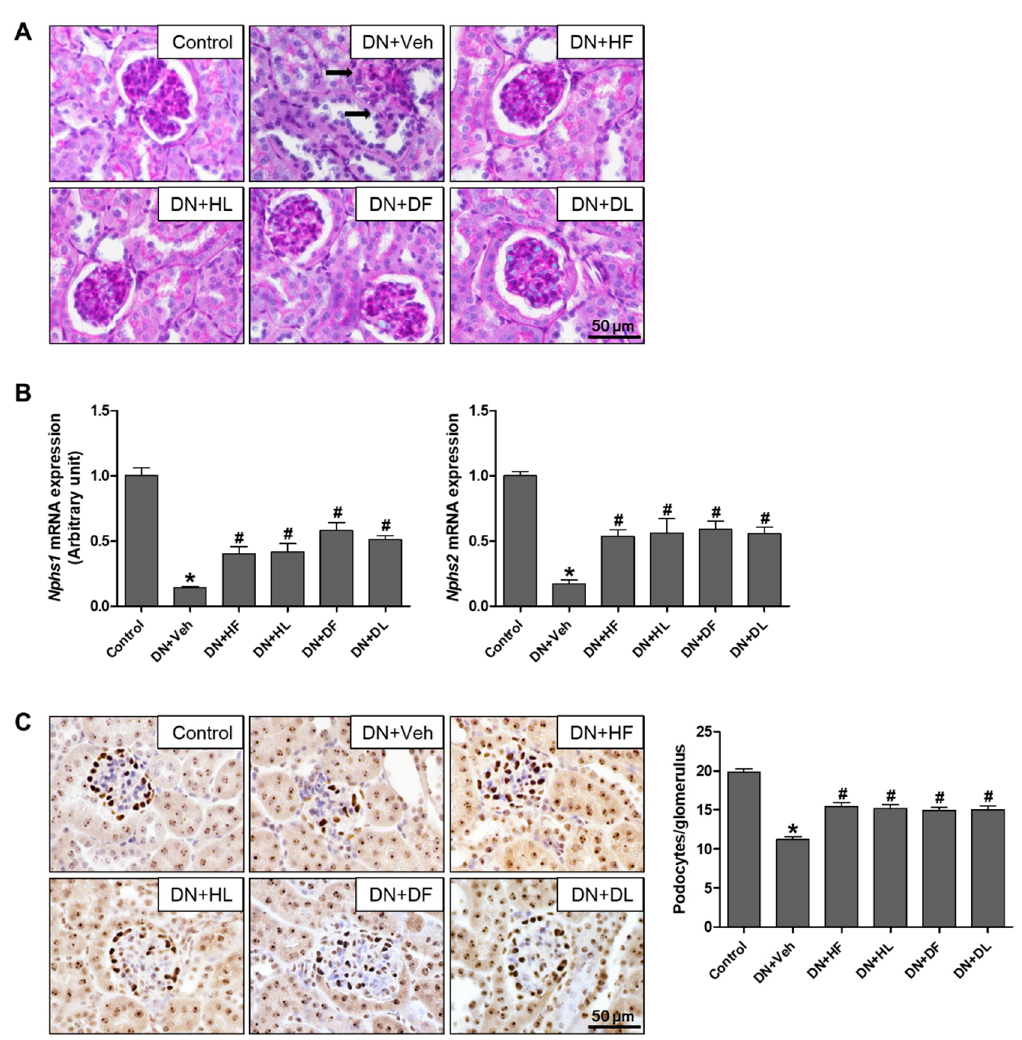
Figure 2. AM extract treatment reduced glomerular lesions in DN mice. Kidney tissues were processed for PAS staining and representative images are shown ( A ). Arrows indicate damaged glomeruli. Relative mRNA expression levels of Nphs1 and Nphs2 were determined by real-time PCR analysis ( B ). Kidney tissues were processed for WT1 immunostaining, representative images were shown, and the number of stained podocyte per glomerulus was counted ( C ). The data are presented as the mean ± SEM. * p < 0.05 versus control, # p < 0.05 versus DN mice. Scale bar, 50 μ m.